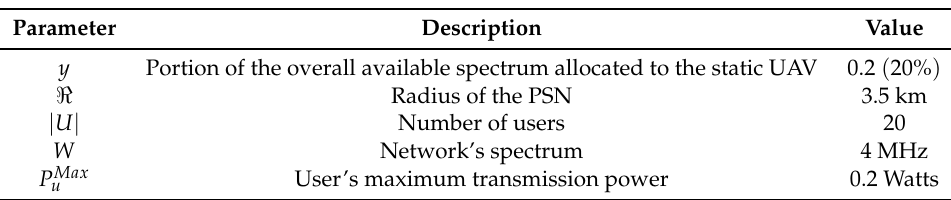
Table 1. Simulation Parameter